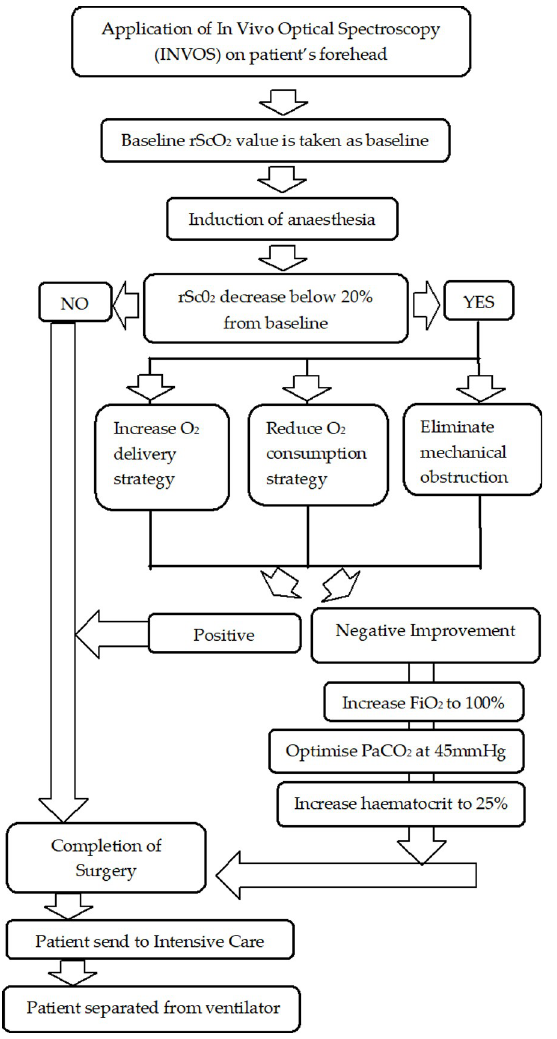
Fig 1. Patient management based on cerebral